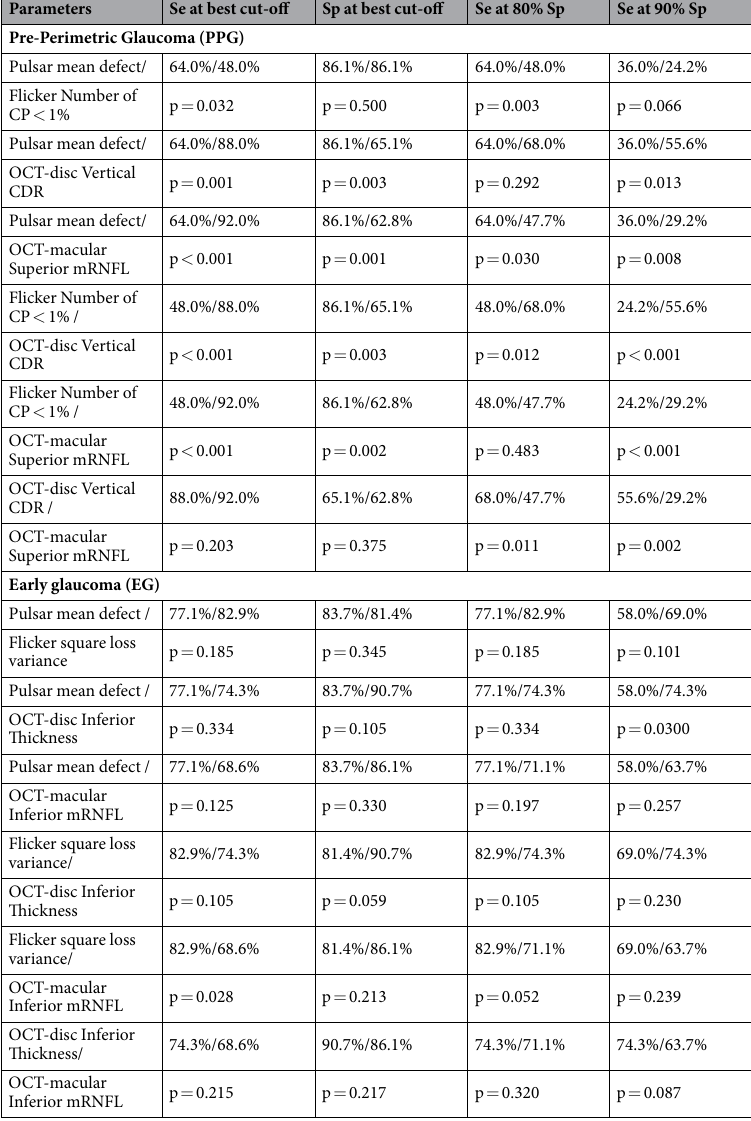
Table 5. Statistical comparison of sensitivity and specificity values at best cut-off and sensitivity values at fixed specificity among each device. Se = sensitivity; Sp = specificity; CP = corrected probability; OCT = optical coherence tomography; CDR = cup to disc ratio; mRNFL = macular retinal nerve fiber layer. Data were analyzed by χ 2